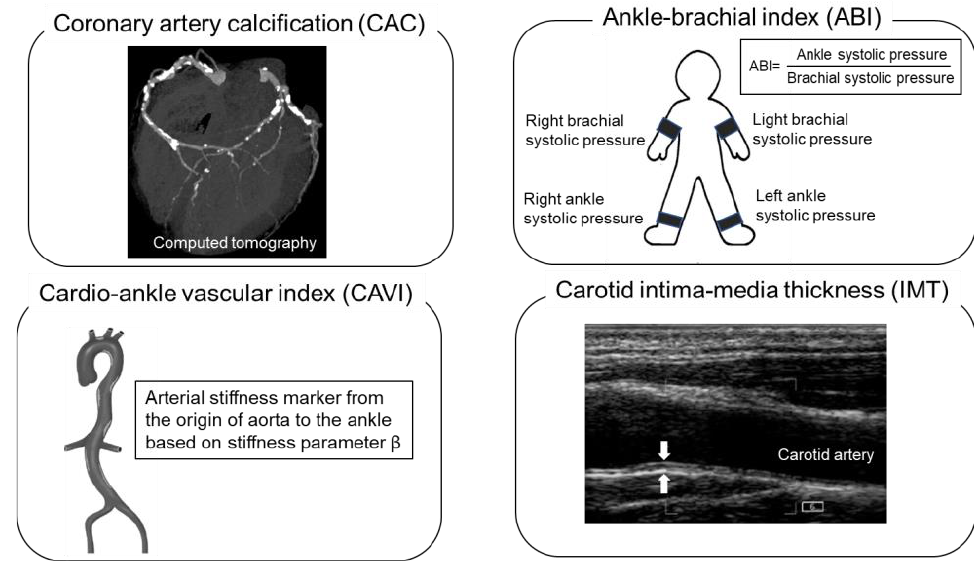
Figure 1. Non-invasive modality of atherosclerosis assessment.